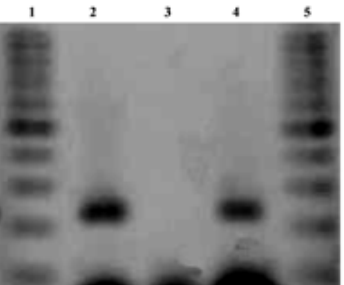
FIGURE 3 - Photography of agarose gel displaying banding of the samples submitted to PCR. Channels 1 and 5 have standard marker of 100 base pairs. Channel 2 with PCR product of cells in culture (positive control). Channel 3 with PCR product of the bone tissue sample of animal gfp - (negative control). Channel 4 with PCR product of the paraffinized bone tissue sample of one animal treated with MSC/ gfp +